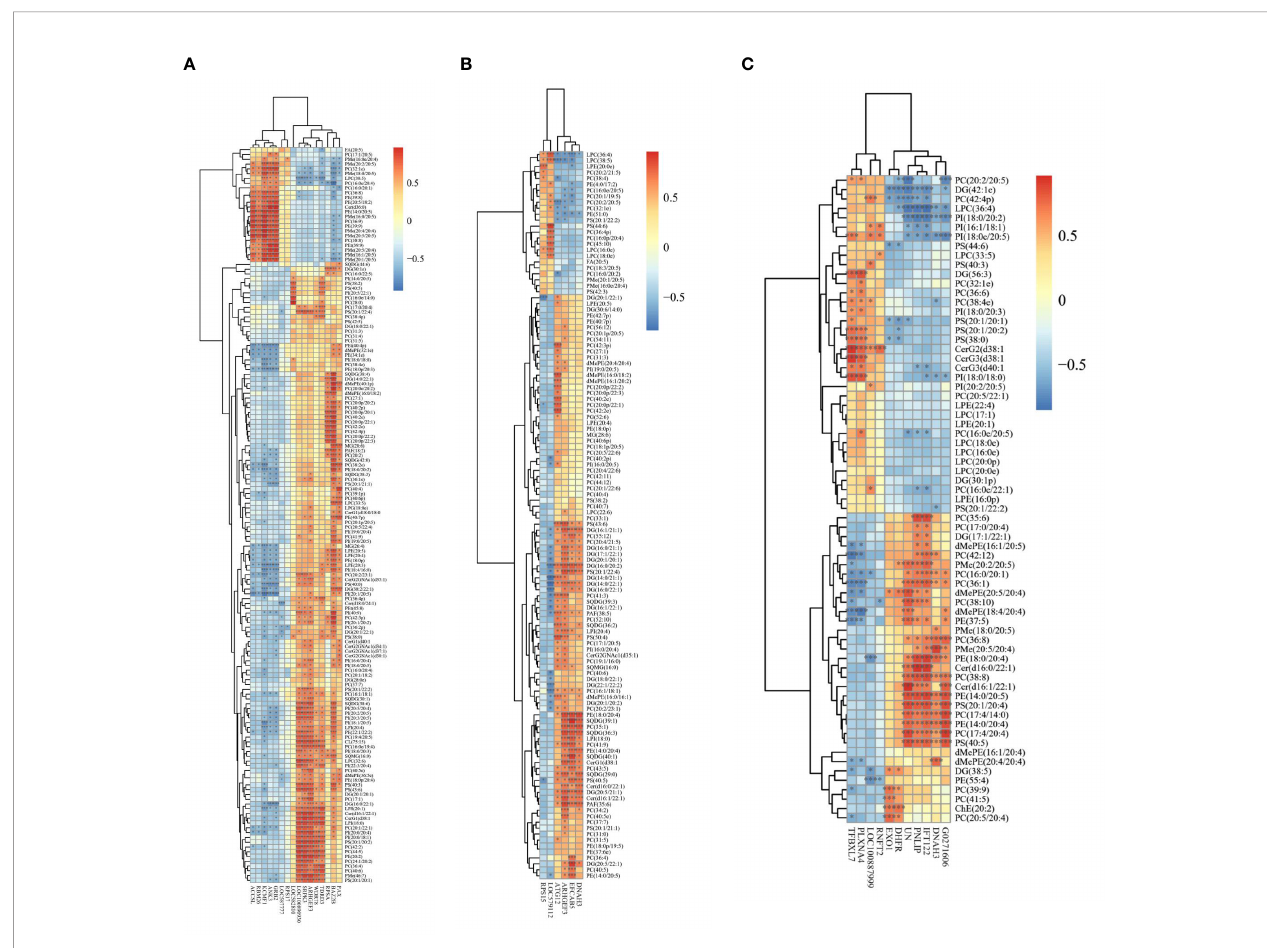
FIGURE 5 | Heatmaps of the correlation analysis based on differentially expressed genes and signi fi cantly changed lipid molecules from pairwise comparisons (A) H vs L; (B) H vs M; (C) M vs